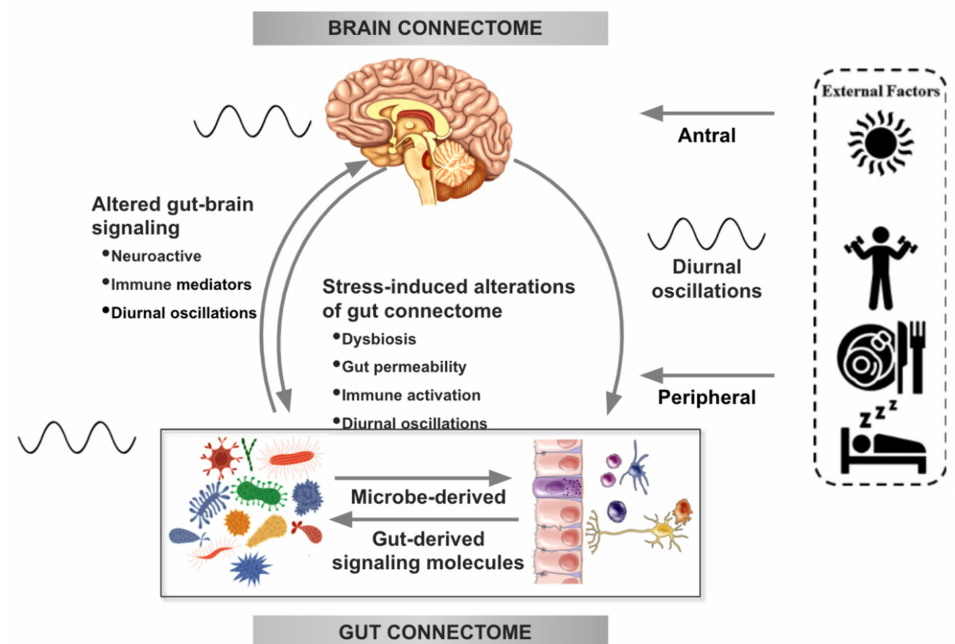
Figure 1. Bidirectional interactions within the brain gut microbiome (BGM) system are modulated by diurnal oscillations. Outputs generated by the central autonomic brain network modulate the activity of various components of the gut connectome (immune, endocrine, epithelial cells, gap junctions, smooth muscle, neurons) which influence gut function and interactions of the gut with the microbiome. Sympathetic nervous system outflow from the brain can also modulate gut microbial gene expression and function directly. Both gut and brain induced modulation of gut microbial metabolites and secretion of neuroactive neuroactive and inflammatory signaling molecules feed back to the brain and modulate the activity of brain networks. Diurnal variations (depicted by an oscillating line), food intake, sleep and physical activity modulate autonomic nervous system (ANS) activity as well as gut microbial composition and function. Oscillations between the brain and the gut are synchronized with the central clock in the hypothalamic suprachiasmatic nucleus. Modified with permission from Osadchiy et al. [21] and Chaix et al.